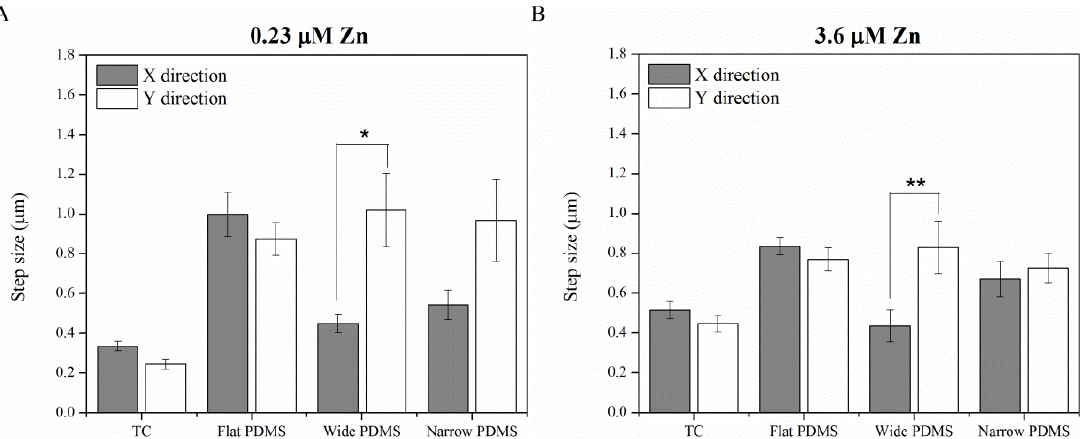
Figure 6. Average cell step size in x and y directions with ( A ) zinc-deprived media; ( B ) serum-level zinc media; and ( C ) zinc-rich media. A single asterisk ( * ) indicates a p < 0.01 difference while double asterisks ( ** ) indicate a p < 0.05